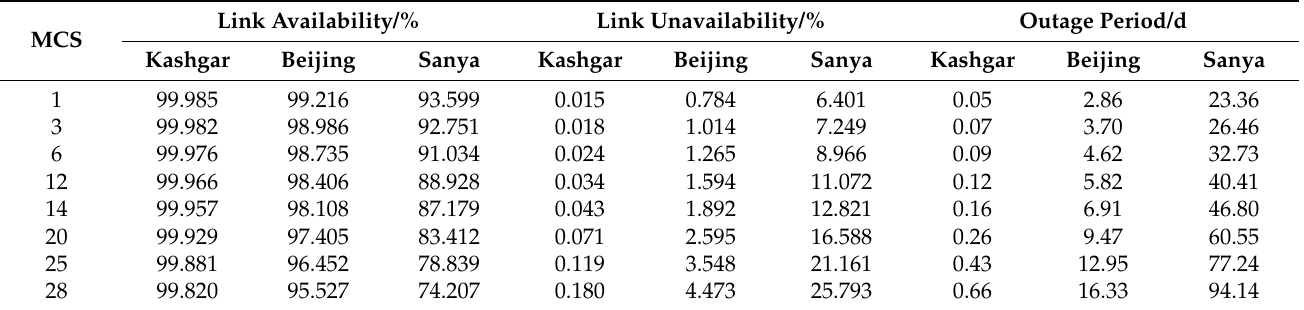
Figure 5. Maximum allowable atmospheric attenuation. Table 4. Link availability, link unavailability and outage period of satellite-to-ground data transmis- sion link at 5 ◦ elevation